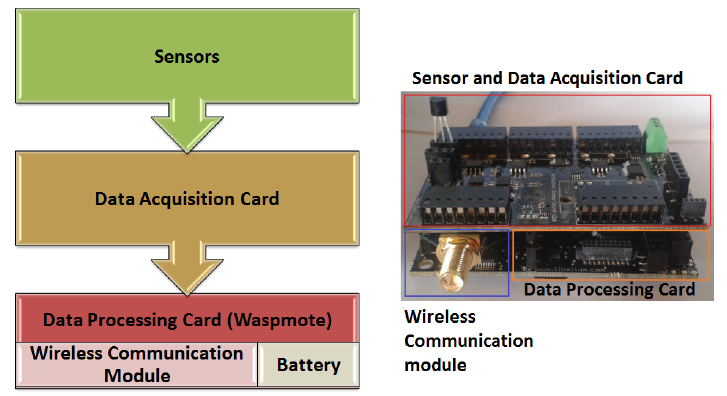
Figure 2. Structure and view of the sensor nodes.